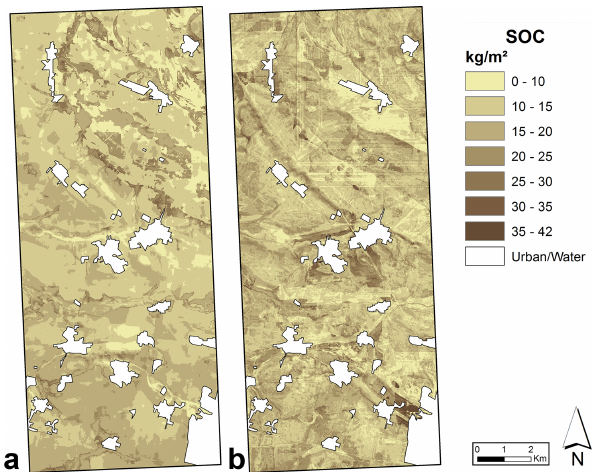
Figure 4. Total SOC stock (topsoil + subsoil) modelled by (a) the di- rect approach and (b) the indirect approach. Overlaid on a hillshade to show relationship with relief and field